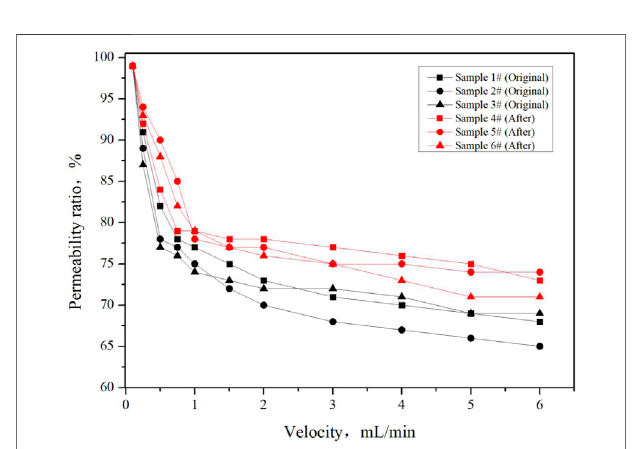
FIGURE 8 | Effect of supercritical CO 2 on velocity